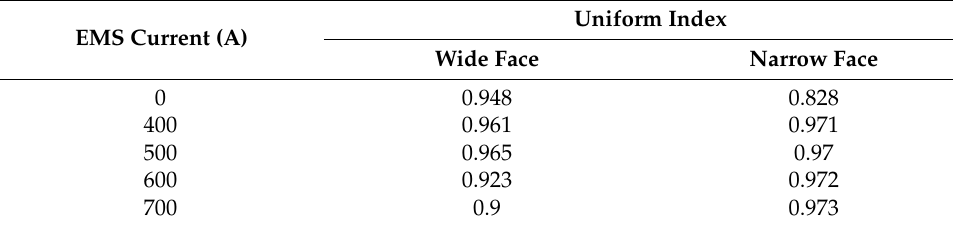
Table 3. Uniform index at z = − 0.4 m under different EMS